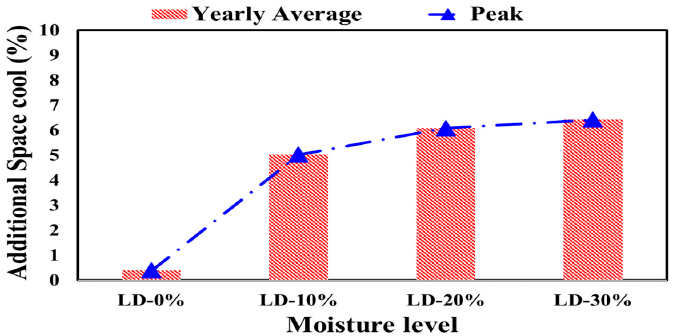
Figure 5. Yearly average and peak additional space cooling percentages employing dry variable thermal conductivity as compared with constant value at different moisture levels in the hot climate of UAE.